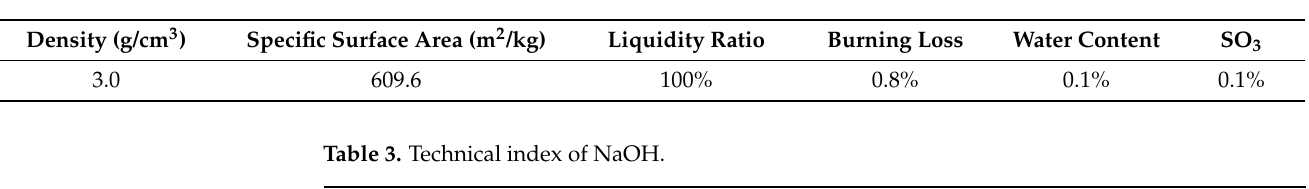
Table 2. Technical index of slag.